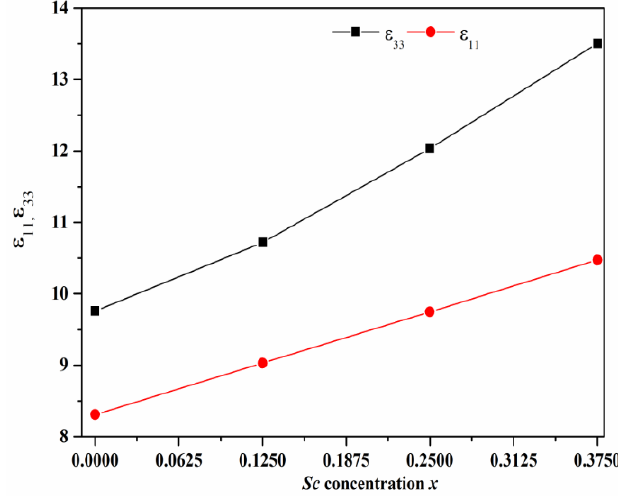
Figure 3. Calculated dielectric constants ε 11 and ε 33 as a function of Sc concentration for w-Sc x Al 1-x N .